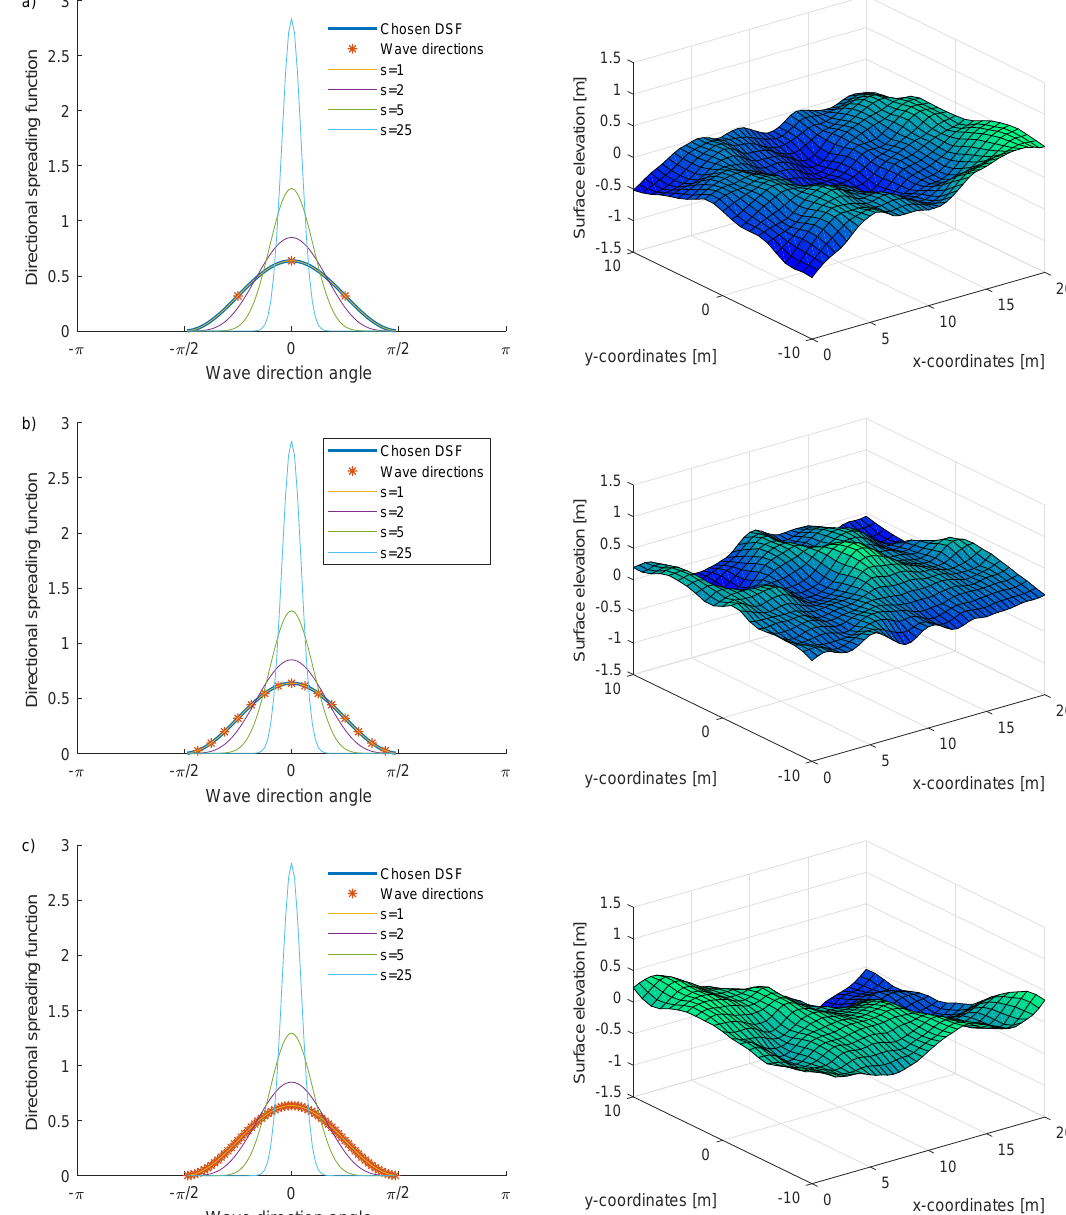
Figure 3. Directional spreading function D ( χ m − ¯ χ ) in Equation (21) for s = 1 and increasing wave directions from 3, 15 and 63, as shown in the directional spreading function plots. A time instant of the surface elevation is shown to the right. ( a ) three wave directions χ m = ± m π /4 with m = 0,1; ( b ) 15 wave directions χ m = ± m π /16 with m = 0, . . . ,7; ( c ) 63 wave directions χ m = ± m π /64 with m = 0, . . .